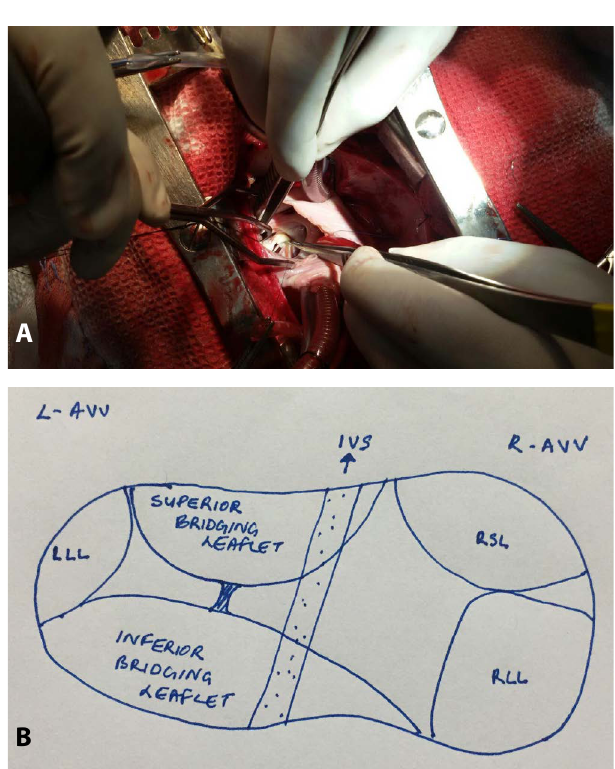
Fig. 1 – A: Intraoperative picture showing the two orifices of the mitral valve. B: Sketch of atrioventricular valves and left atrioventricular valve is a double orifice mitral valve.